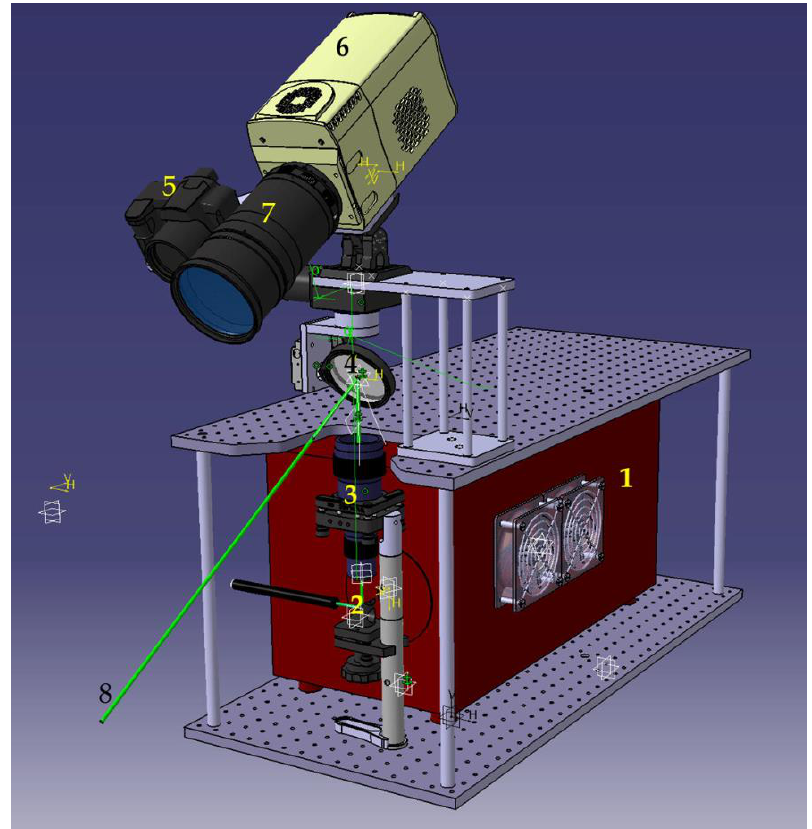
Figure 1. In the picture the following components are depicted: 1. laser, 2. mirror M1, 3. beam expander, 4. scanning mirror M2, 5. camera, 6. ICCD, 7. collecting optics, 8. laser beam.